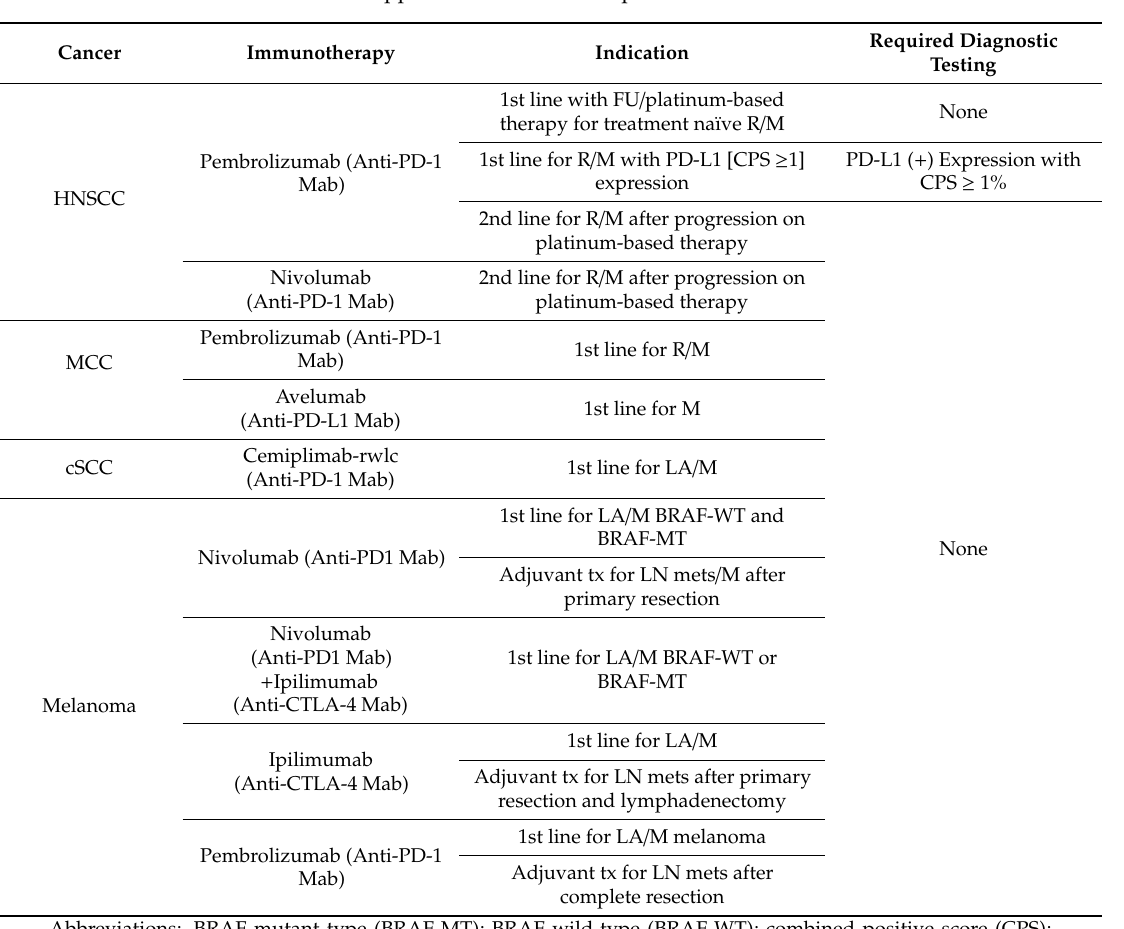
Table 2. FDA-approved immune-checkpoint inhibitors in